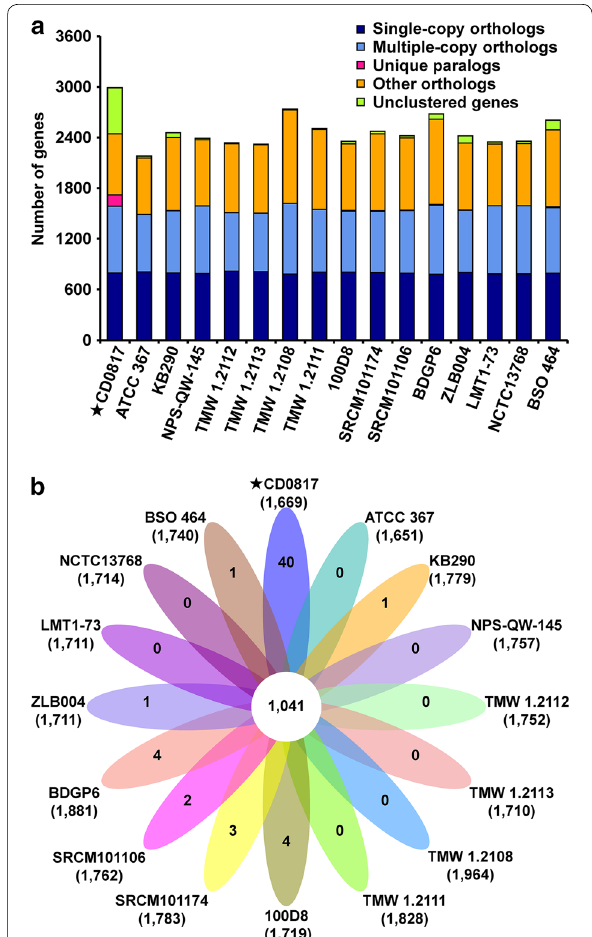
Fig. 3 Gene family analysis of CD0817 and 15 completely sequenced reference Lactobacillus brevis strains. a Barchart of ortholog and paralog in each strain. b Venn diagram of shared and unique families in each strain. Number in the center of diagram indicates shared families. Numbers in outer end of ellipse indicate unique